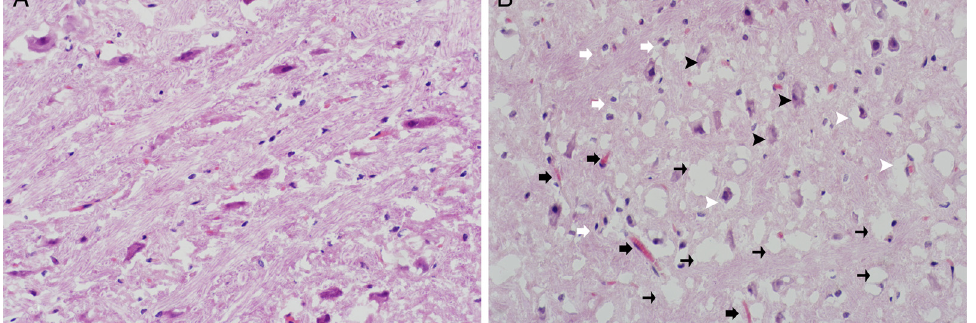
Histomorphological examination H&E staining (40 × ); (A) control group: tissue integrity, general appearance of cells is natural, no changes in neuron size. (B) RF-EMF group: degeneration of neurons in the ventral cochlear nucleus, degradation (black arrowheads), in addition to some decrease in neuron size, shrunken pyknotic cells (white arrowheads). Increased numbers of glial cells (white arrows) and areas with increased vascularization (black arrows). Intense vacuolization in tissue (thin black arrows) and edematous areas.